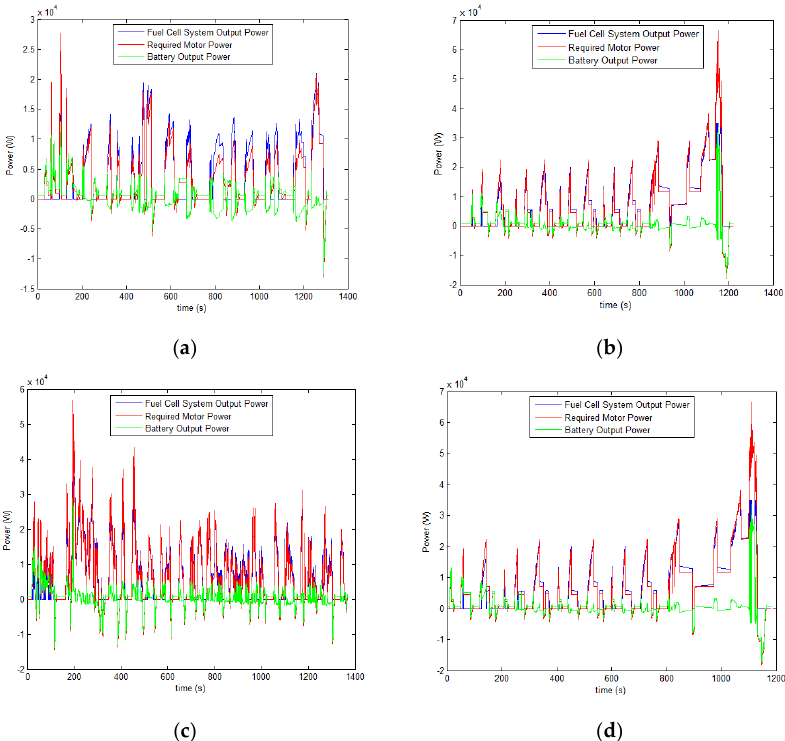
Figure 6. Energy storage system efficiency of discharging: ( a ) China, ( b ) ECE+EUDC, ( c )UDDS, and ( d ) NEDC.